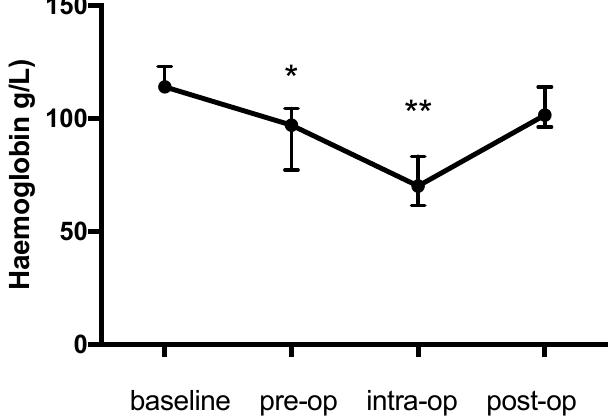
Figure 1. Packed cell volume during the study period. * p = 0.044 pre-op compared to baseline; ** p = 0.002 intra-op compared to baseline.